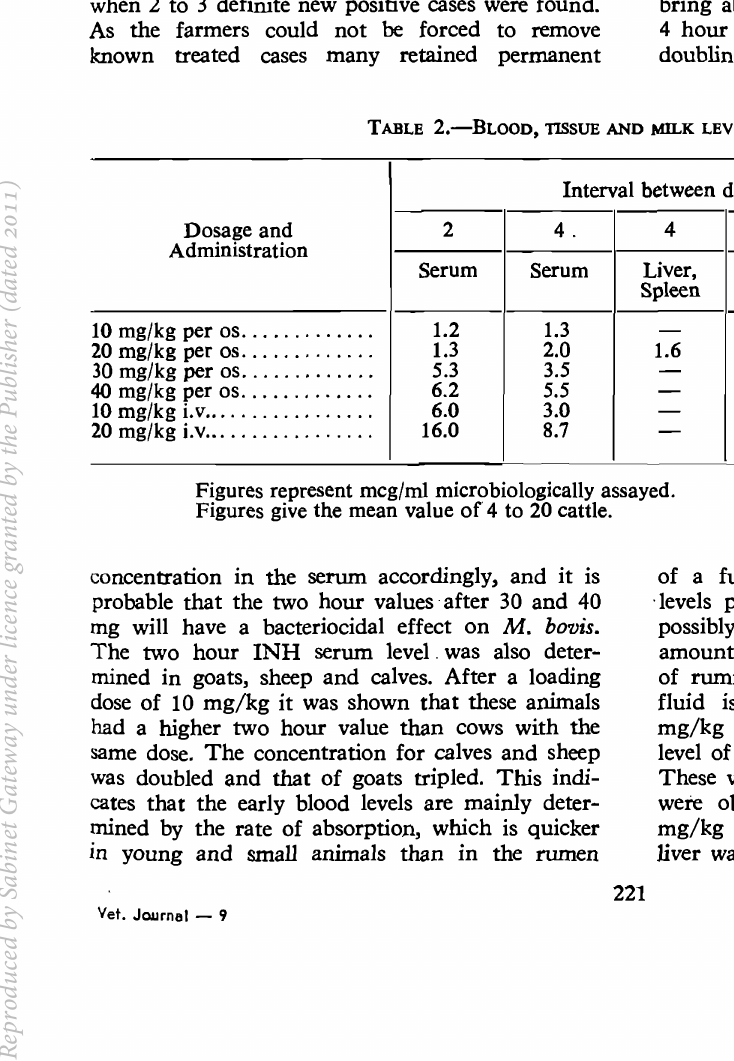
TABLE 2.-BLOOD, TISSUE AND MILK LEVELS OF ISONIAZID Interval between dosing and bleeding in